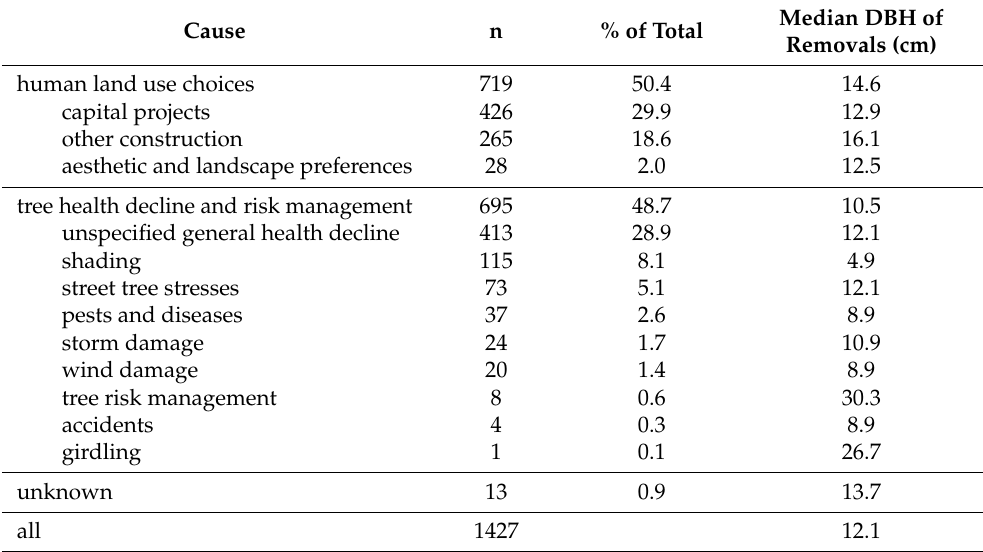
Table 1. Causes of tree removal (n = 1427) on the Penn campus, 2003–2014, and the median DBH of those removals (for the subset of 1407 removed trees that had DBH